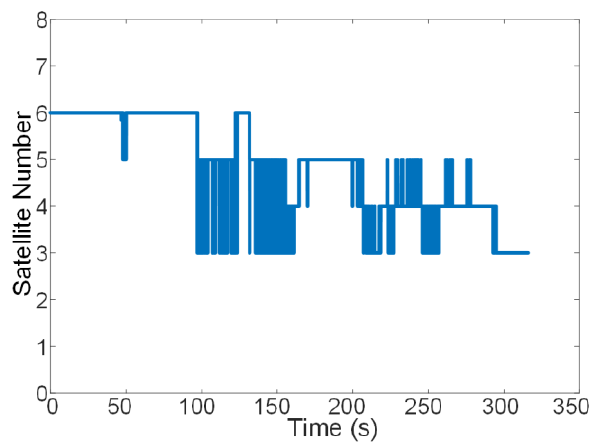
Figure 27. Satellite visibility of roads in the city canyon test.